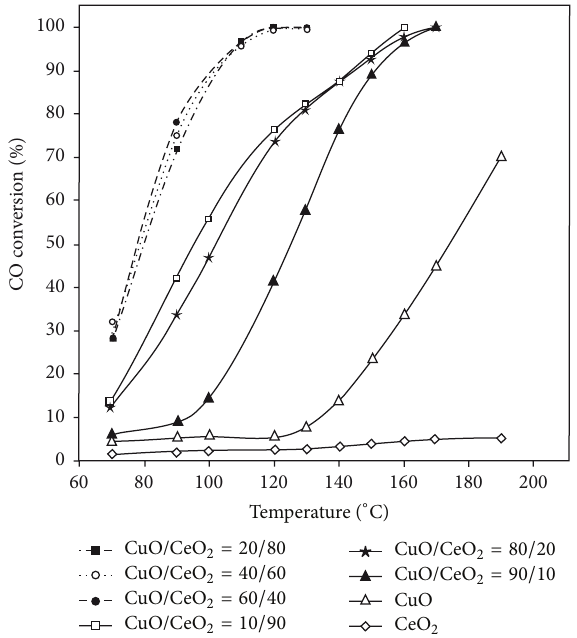
Figure 4: CO oxidation performances of CuO/CeO 2 catalysts for various weight ratios with their pure oxides are also shown. Feed composition (v/v): 1% CO, 1% O 2 , and 98%